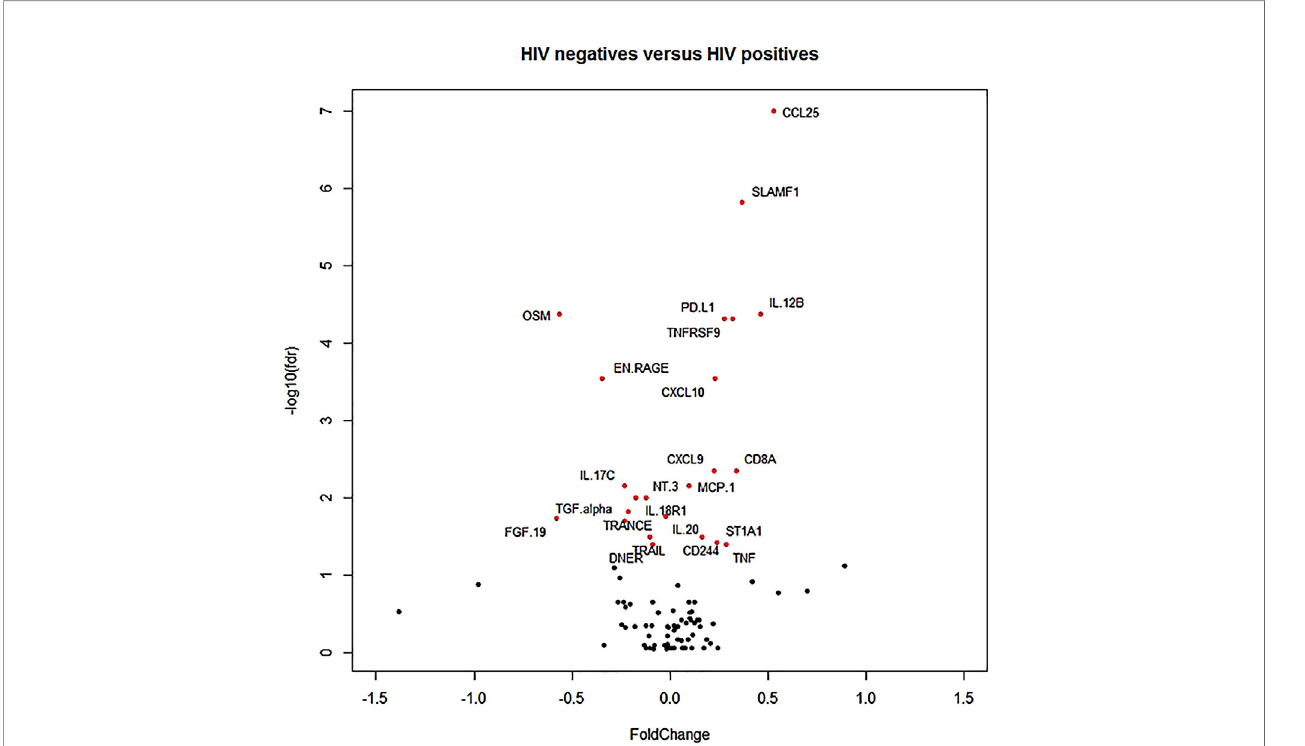
FIGURE 2 | Volcano plot. The red dots indicate the markers that differed at a false discovery rate corrected p-value